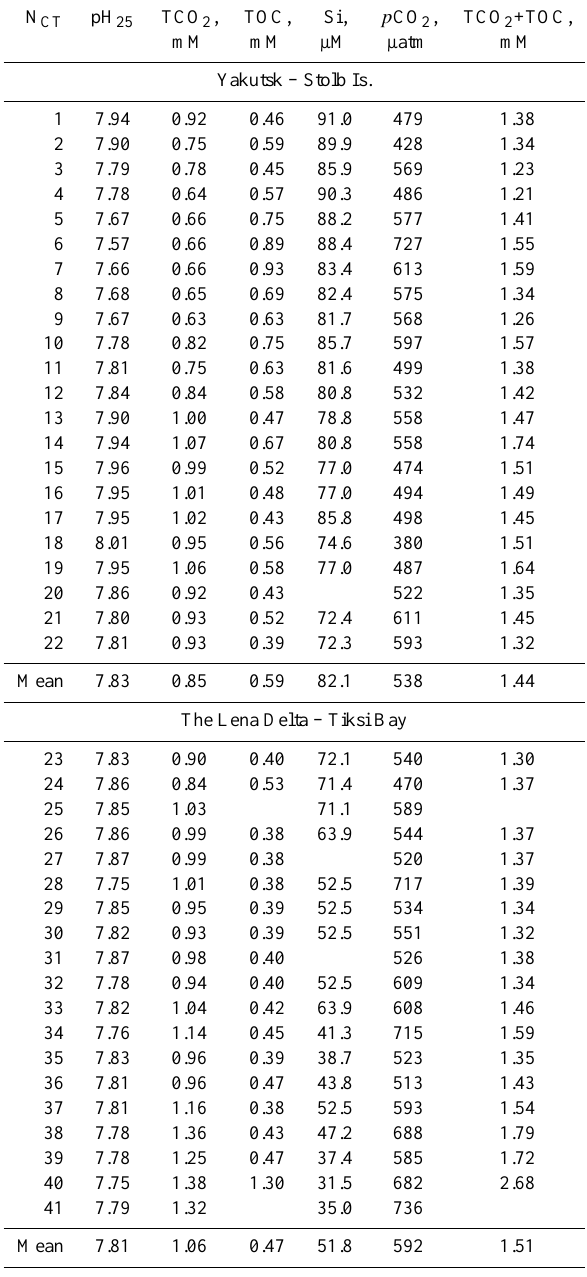
Table 1. Major components of carbon cycling and silicates sampled between Yakutsk, the Lena Delta, and Tiksi Bay (late August–early September,